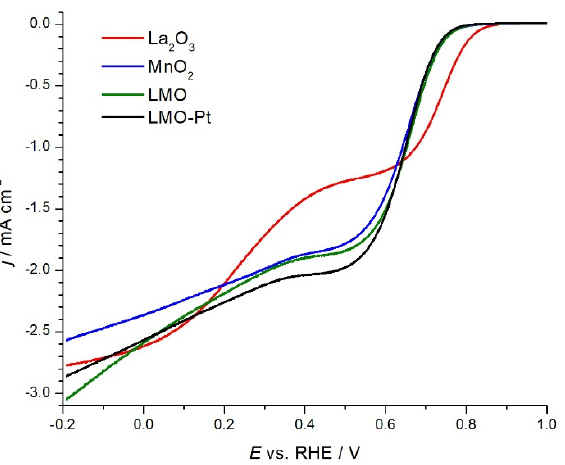
Figure 2. ORR activities of La 2 O 3 , MnO 2 , LMO, and LMO-Pt electrode materials at the scan rate of 2 mV s − 1 and electrode rotating speed of 1000 rpm; 0.1 M NaOH, 25 ° C.